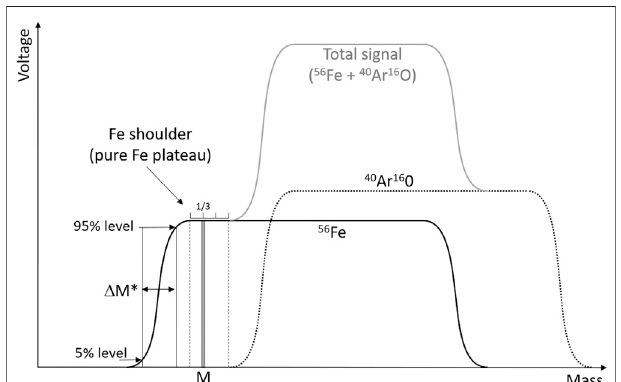
FIGURE 1 | Schematic of the peak shapes for 56 Fe and the 40 Ar 16 O interference. The instrument is set to perform the measurements at mass M, chosen at 1/3 of the pure Fe plateau (free of interference), that is, the Fe shoulder, which is de fi ned as the fl at part of the Fe peak to the left of the Δ M*. 40 Ar 16 O signal. The resolving power, R power (5, 95%), is calculated as M/ Adapted from Weyer and Schwieters